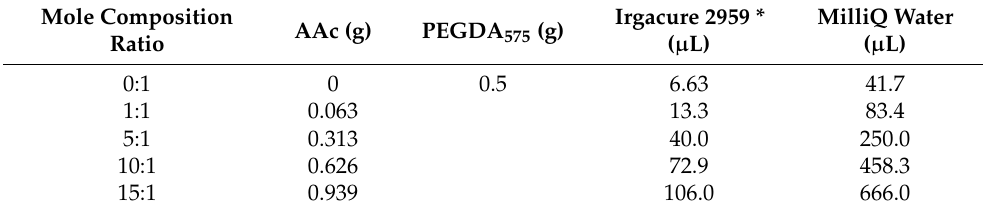
Table 1. Reactive amounts used to synthesize the hydrogels net-poly (AAc- co -PEGDA 575 ).